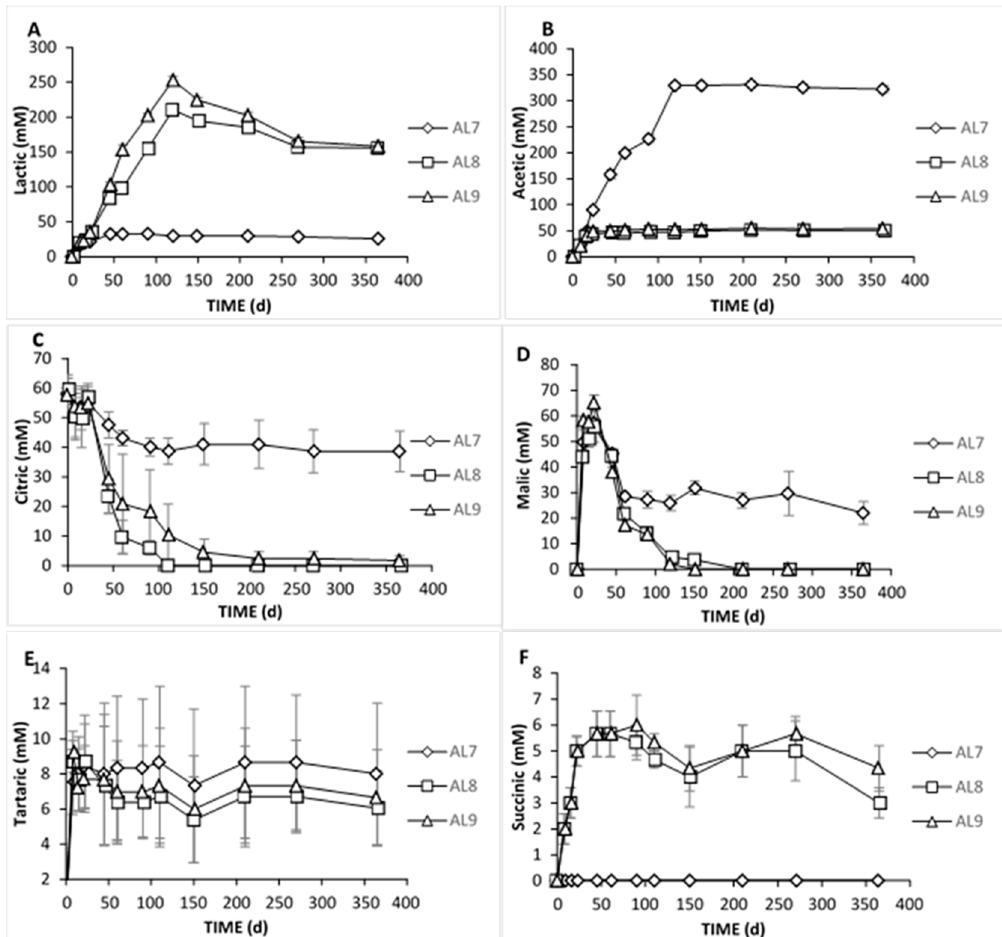
Figure 5. Changes in the concentration (mM) of organic acids (lactic, A ; acetic, B ; citric, C ; malic, D ; tartaric, E ; and succinic, F ) during spontaneous ( ◊ ), inoculated (10% NaCl) ( □ ), and inoculated (7% NaCl) ( ∆ ) fermentation of Cypriot green cracked table olives. Data points are expressed as means and standard deviations of three replicates.